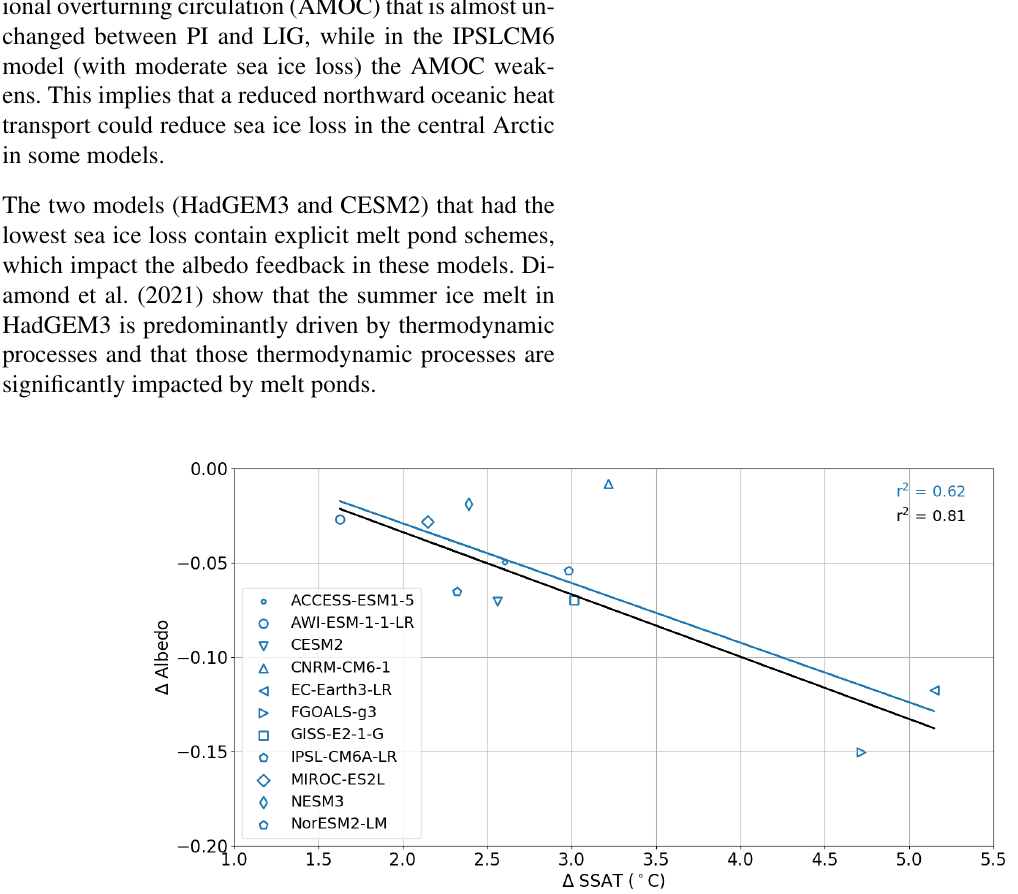
Figure A1. LIG–PI change in albedo over Arctic sea ice as a function of LIG–PI change in SSAT ( ◦ C) over the ice. The r 2 values and the linear fit lines are for the models including CNRM (blue) and excluding CNRM (black). The CNRM model (upward-pointing triangle) is an outlier that influences the strength rather than the nature of the